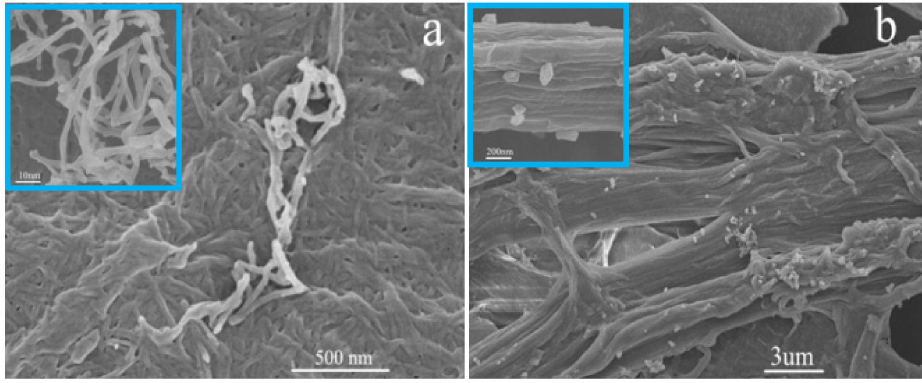
Figure 3. ( a ) SEM micrograph of NCC; ( b ) SEM image of NCC-UPy.